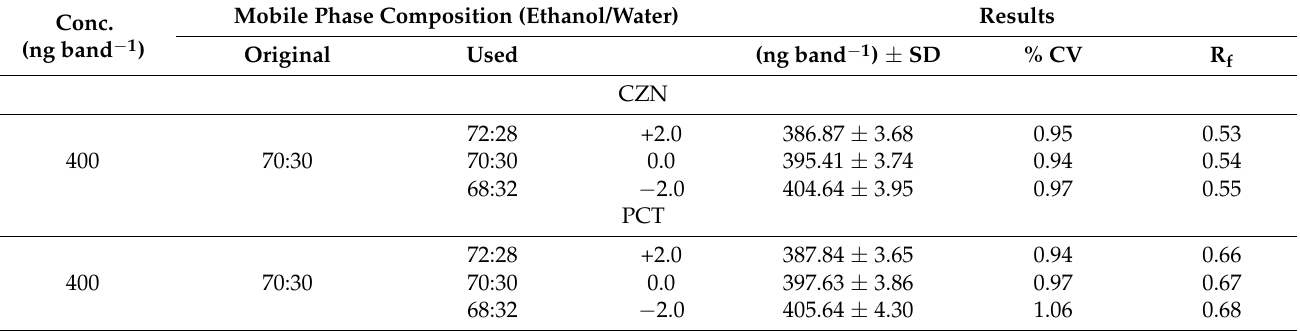
Table 5. Robustness evaluation of CZN and PCT for the HPTLC-UV methodology (mean ± SD; n =